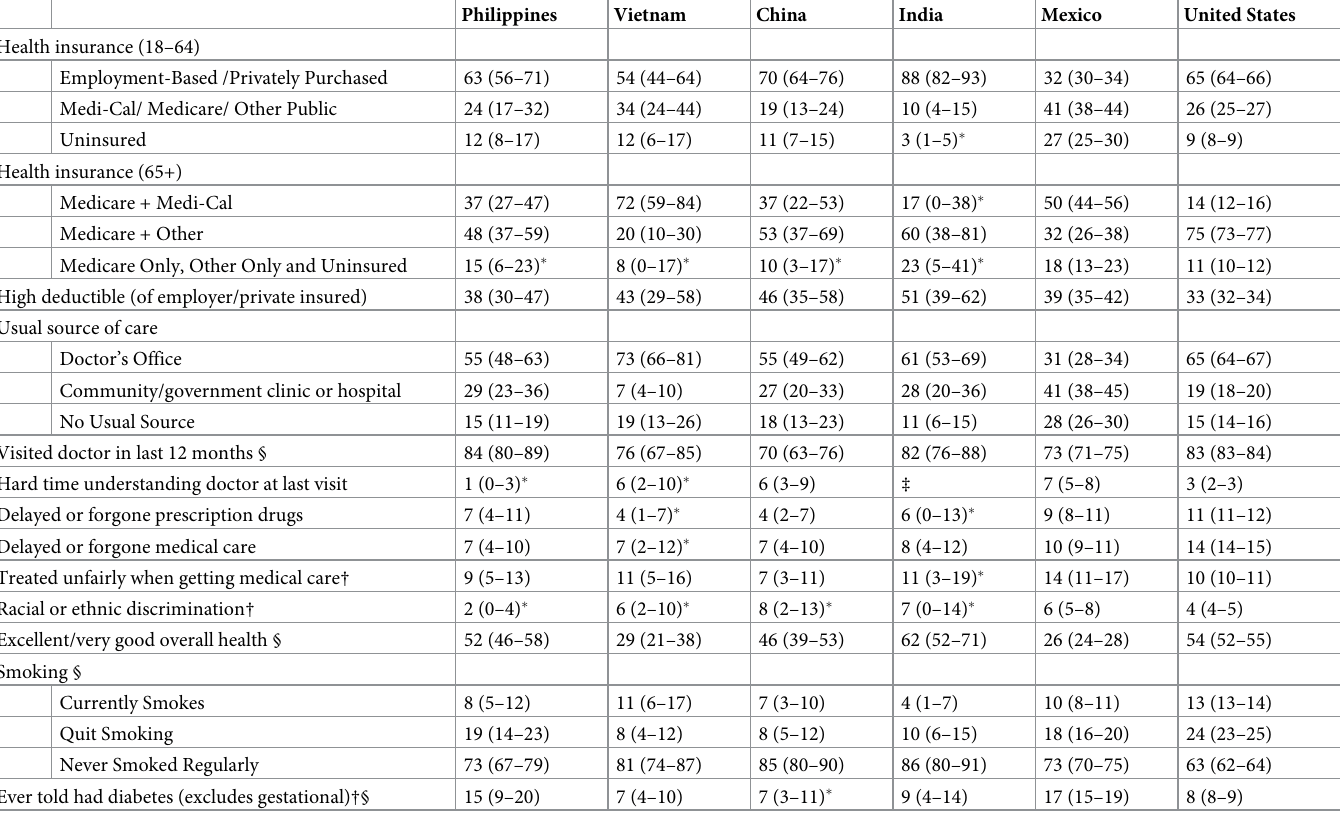
Table 2. Healthcare access and utilization by country of birth, California